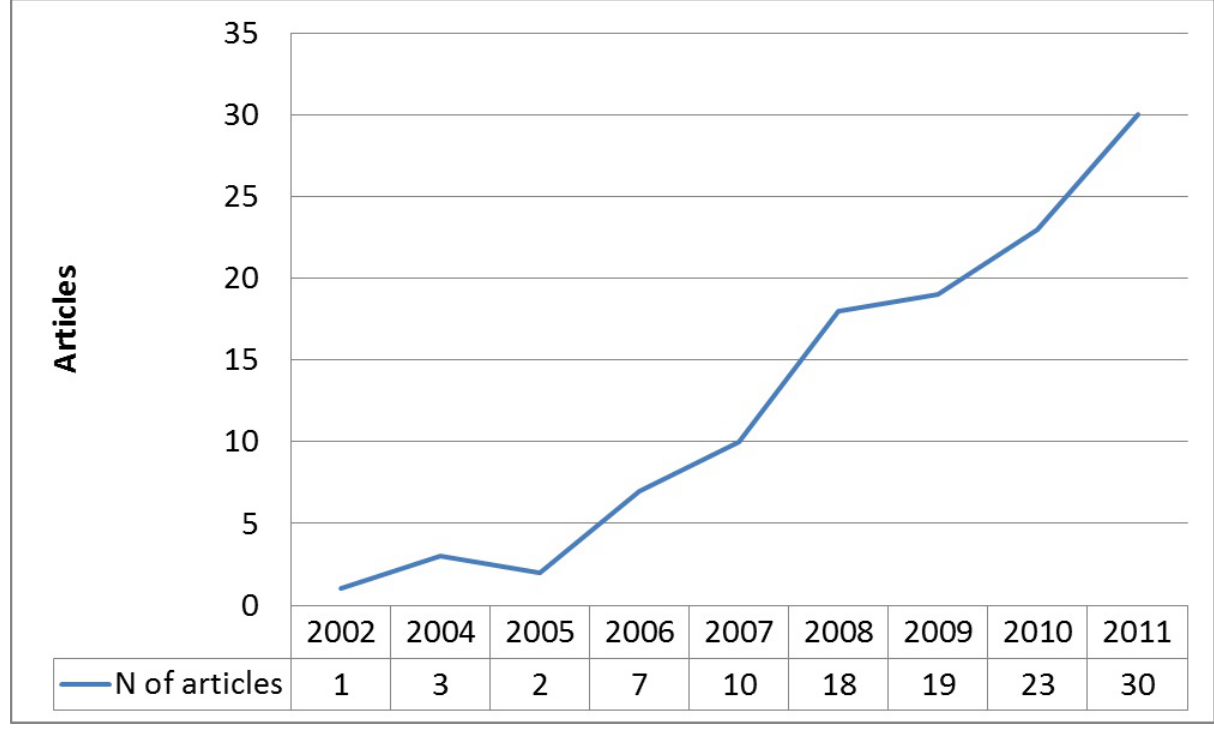
Figure 2. Distribution of articles over time.